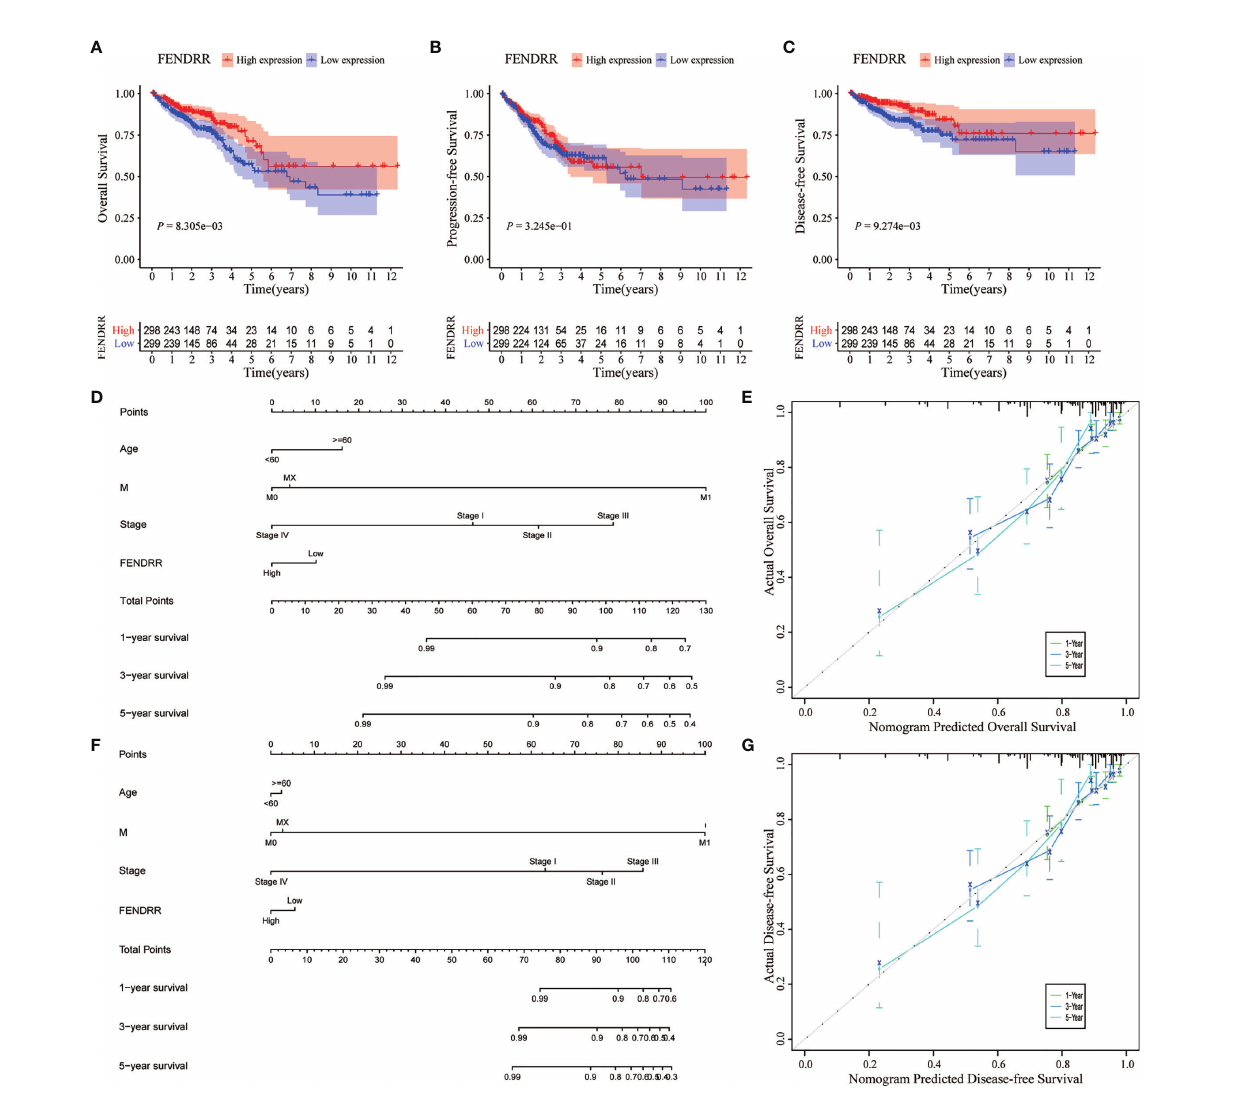
FIGURE 6 | Effect of fetal-lethal non-coding developmental regulatory RNA (FENDRR) expression on colon adenocarcinoma/rectum adenocarcinoma (COAD/READ) prognosis. (A – C) Kaplan-Meier analysis for overall survival (OS), disease-free survival (DFS), and progression-free survival (PFS) in relation to FENDRR expression. (D, F) Nomograms for predicting OS and DFS. (E, G) Calibration curves of nomograms. X-axis, survival status predicted by the nomogram; Y-axis, actual observed survival status.